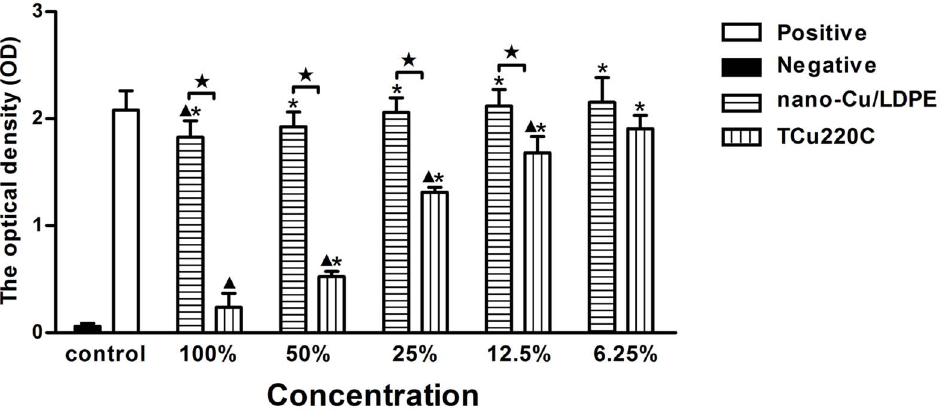
Figure 1. The OD values of the extracts of the nano-Cu/LDPE and TCu220C IUD for 1 d. * p , .05 compared with the positive group; m p , .05 compared with the negative group; w p , .05 between two groups.